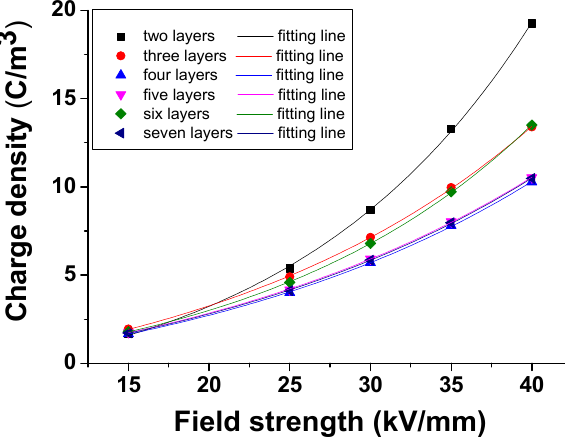
Figure 6. Interface charge density at steady state under different electrical field strengths (20 ℃ ). Table 2. Fitting coefficients for interface charge density absolute value at steady state (1800 s) under different electrical field strengths for multi-layer oil-paper insulation.